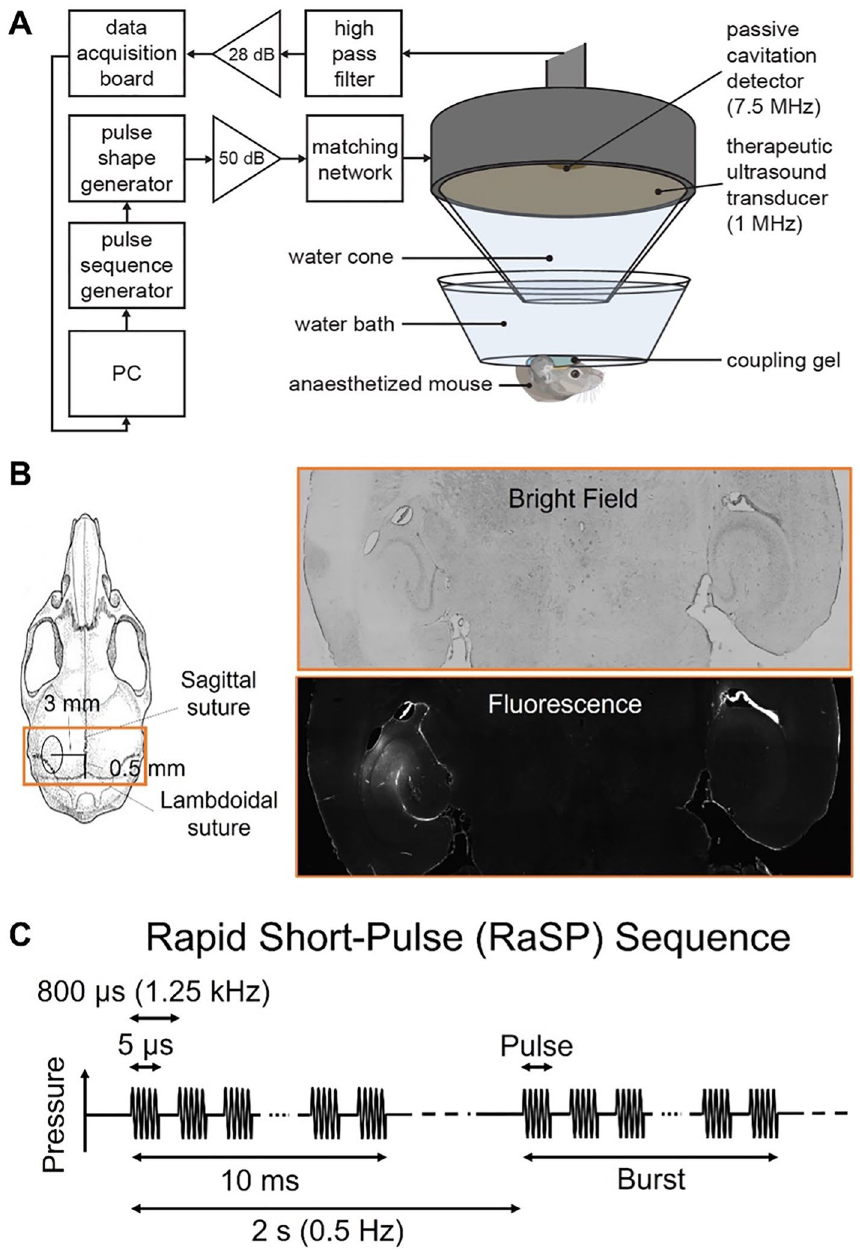
Figure 1. Ultrasound experimental set-up. ( A ) A 1-MHz single-element spherical-segment focused ultrasound transducer was driven by two function generators through an amplifier and a matching network. A passive cavitation detector, placed in the central opening of the transducer such that their foci overlapped, was used to monitor microbubble activity in real time. ( B ) The focal center of the beam was positioned 3 mm inferior to the skull, and 3 mm lateral and 0.5 mm anterior to the intersection of the lambdoidal and sagittal sutures to target the left hippocampus. The right hippocampus, not exposed to ultrasound, was used as a control region to account for background fluorescence within the same mouse. ( C ) A rapid short-pulse (RaSP) ultrasound sequence was emitted to stimulate intravenously administered microbubbles for blood–brain barrier disruption. This sequence consisted of thirteen 5-cycle 1-MHz pulses emitted every 800 μs, grouped into 10 ms bursts emitted every 2 s, with the entire sequence lasting 252